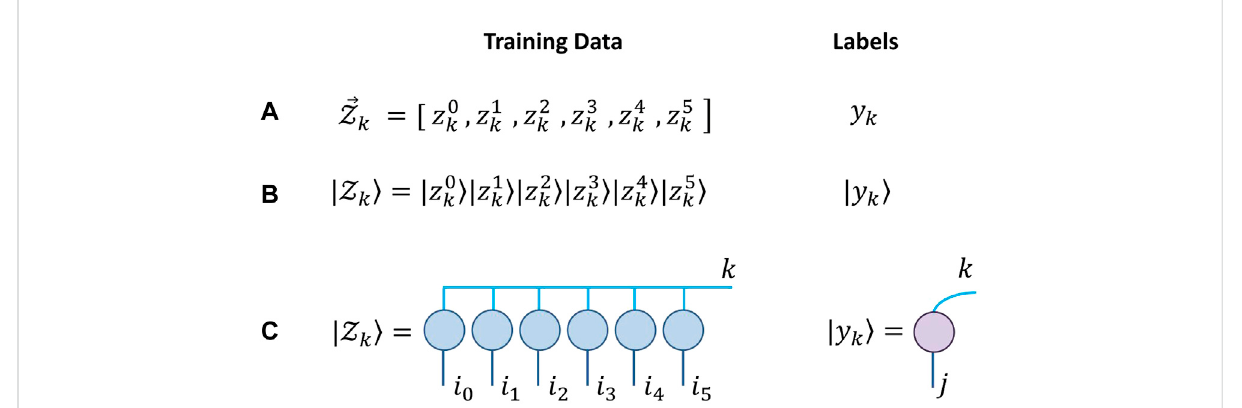
FIGURE 3 (A) The k thtrainingsample (cid:2) Z k isgivenasalength N vectorofintegers z k (modulosomespeci fi edbase d ),andisaccompaniedbylabel y k . (B)